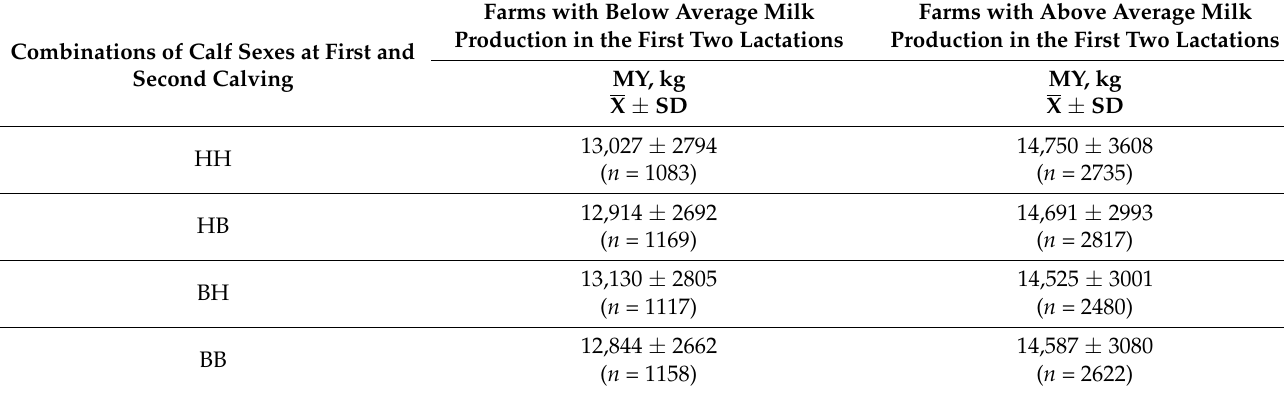
Combinations of Calf Sexes at First and Second